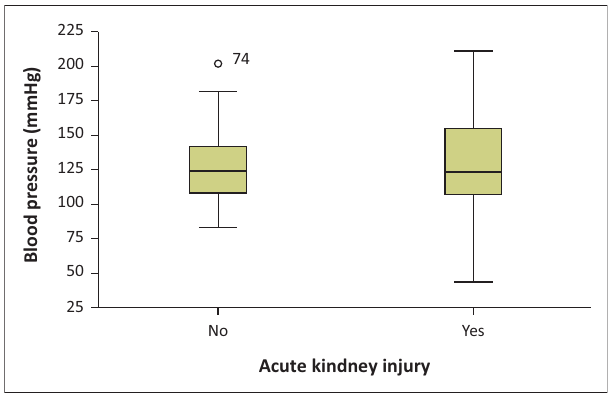
FIGURE 3: Mean blood pressure, gender and acute kidney injury distribution among hospitalised patients who died due to COVID-19.